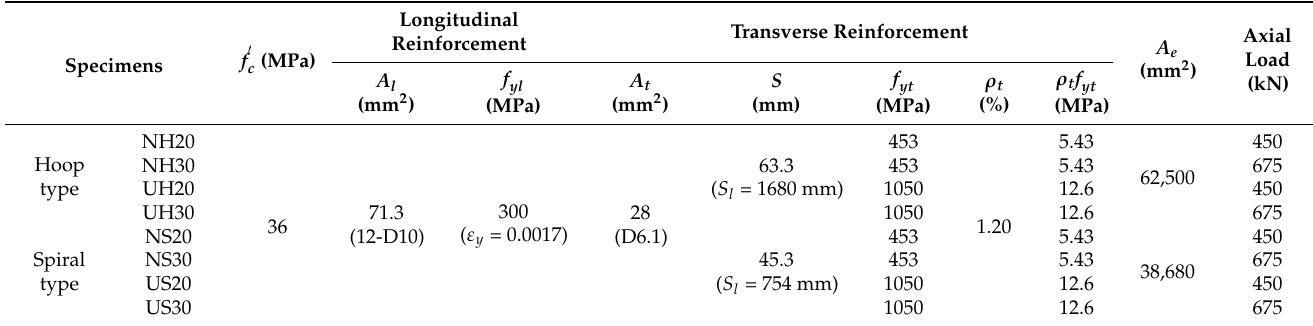
Table 1. Properties of specimens (1 MPa = 145 psi, 1 mm = 0.0394